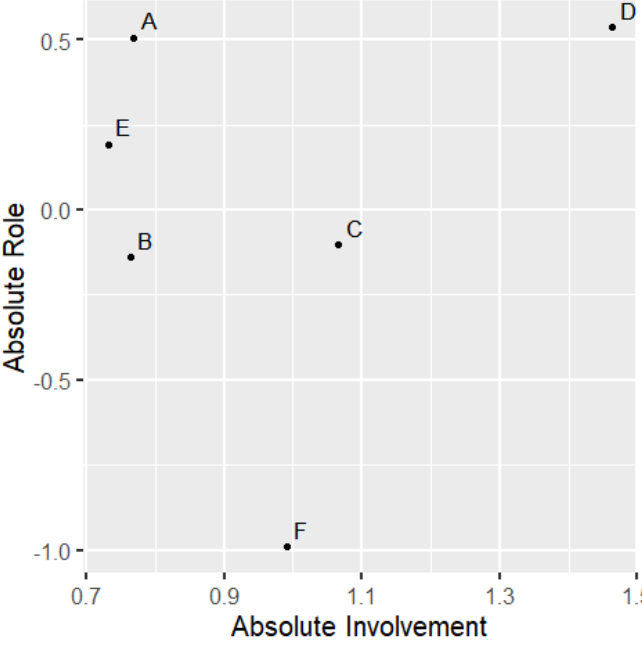
Figure A3. Absolute Role vs. Absolute Involvement of concepts in illustrative